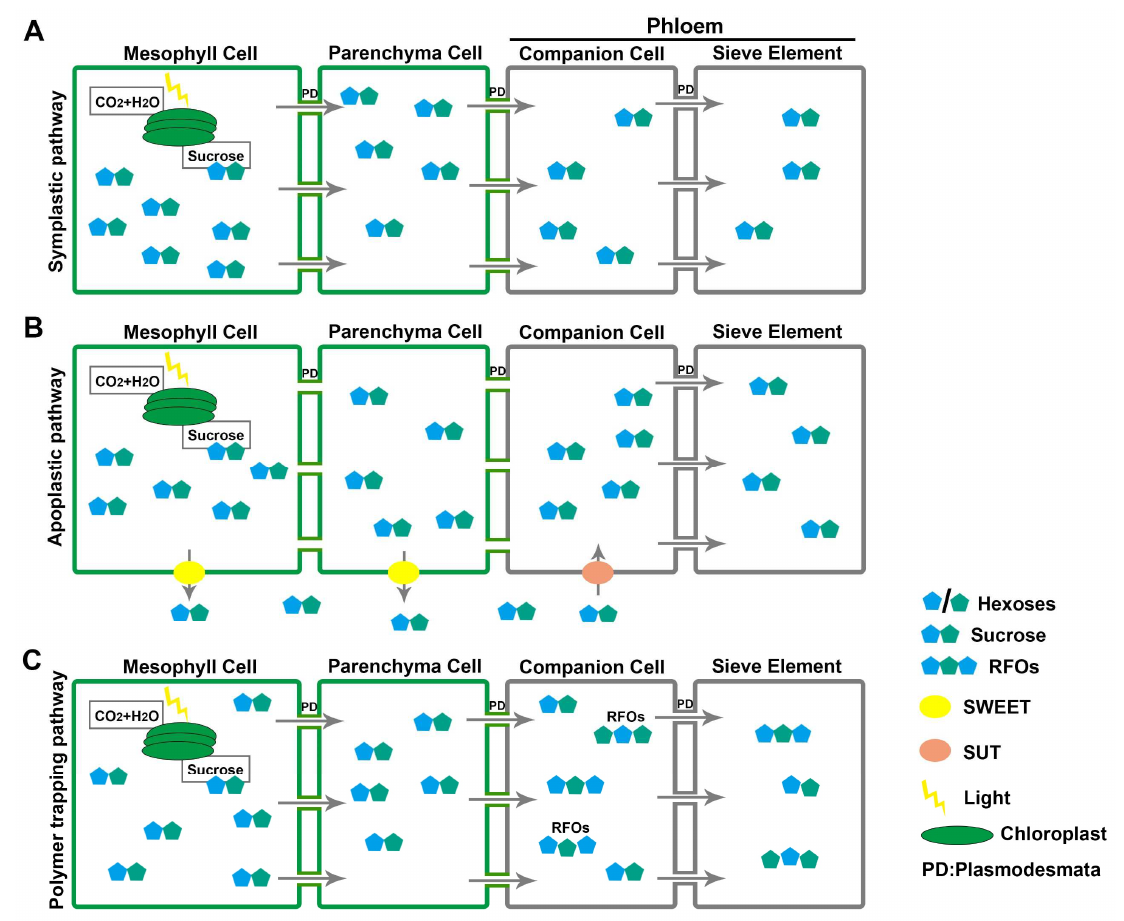
Figure 1. Three strategies for phloem loading. ( A ) Symplastic pathway: sucrose accumulates in mesophyll cells and is passively translocated to the phloem through plasmodesmata (PD) along the concentration gradient. ( B ) Apoplastic pathway: sucrose is exported to the apoplast by SWEETs and, after diffusion, imported into the phloem by SUTs. ( C ) Polymer trapping: sucrose is passively exported to phloem companion cells and synthesized into RFOs that can only move into sieve element cells due to their larger molecular